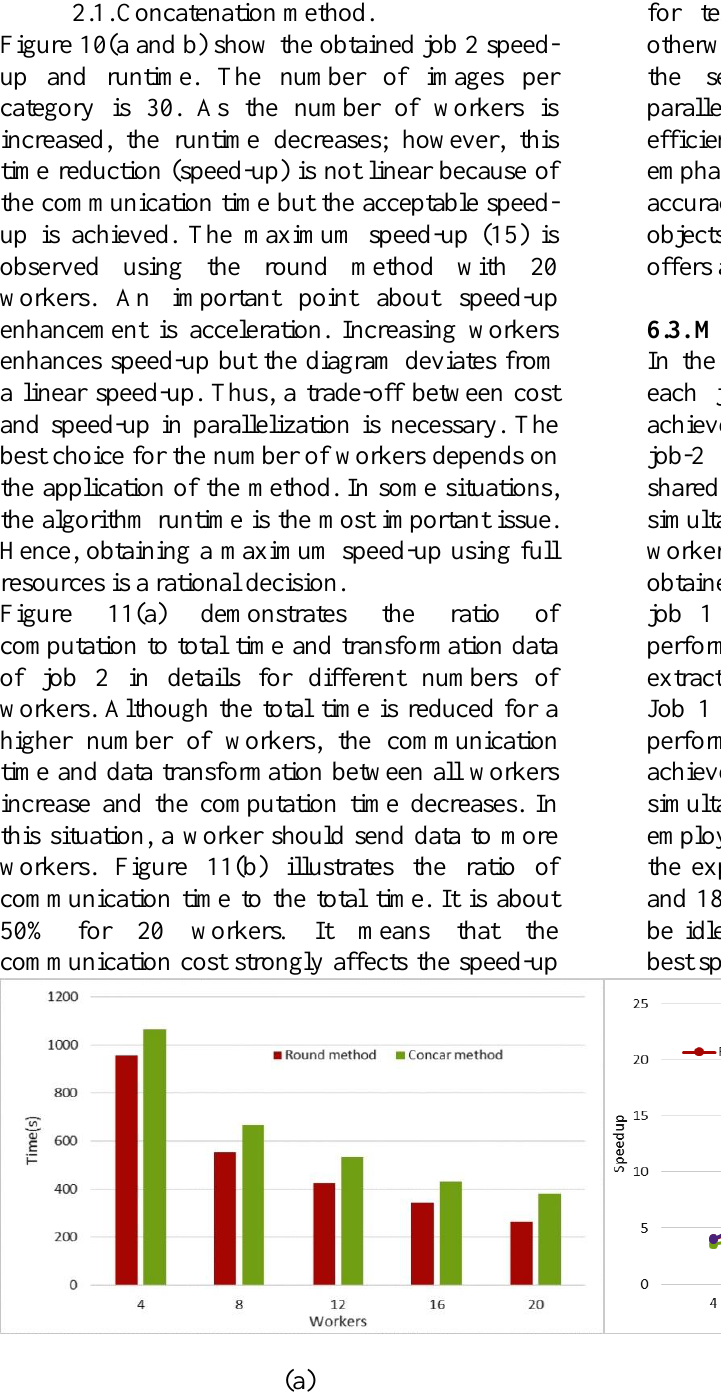
Figure 10. Time taken to run job 2 in two methods, round and concatenation (a). Speed-up of two methods, round and